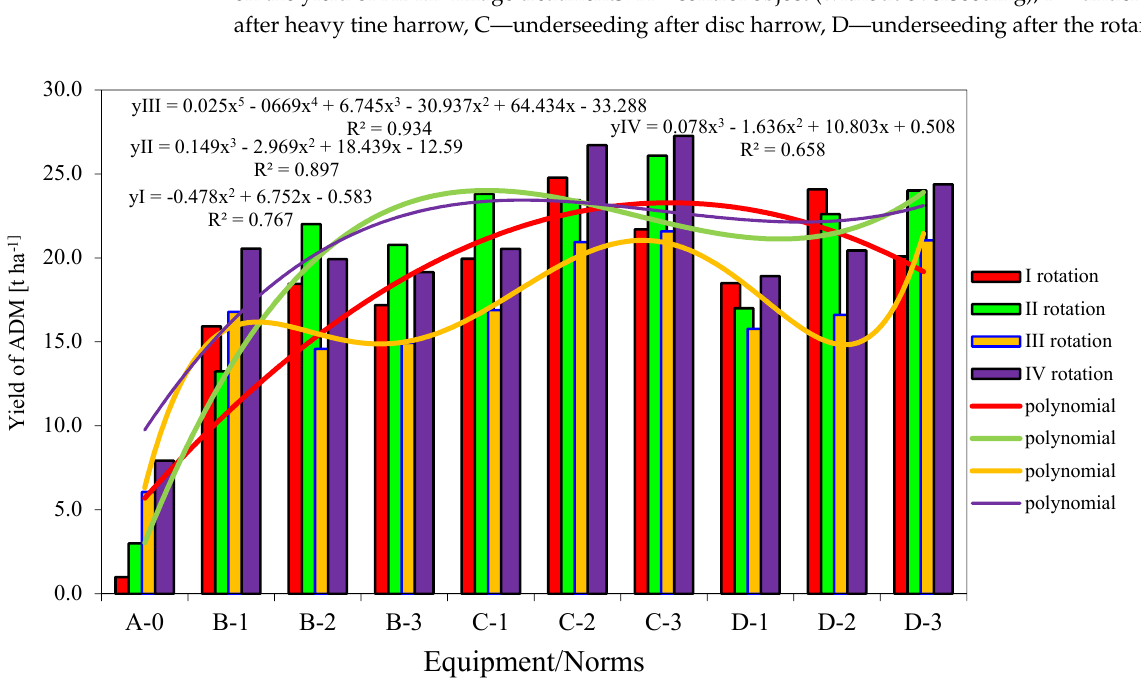
Figure 6. The influence of tillage equipment and reseeding norms on the share of T. repens in the pasture rotations. Tillage treatments: A—control object (without overseeding), B—underseeding after heavy tine harrow, C—underseeding after disc harrow, D—underseeding after the rotary tiller.